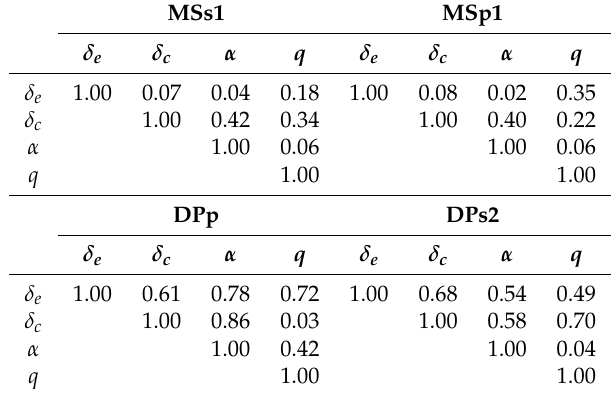
Table 6. Absolute value of the correlation between the real part of the regressors.